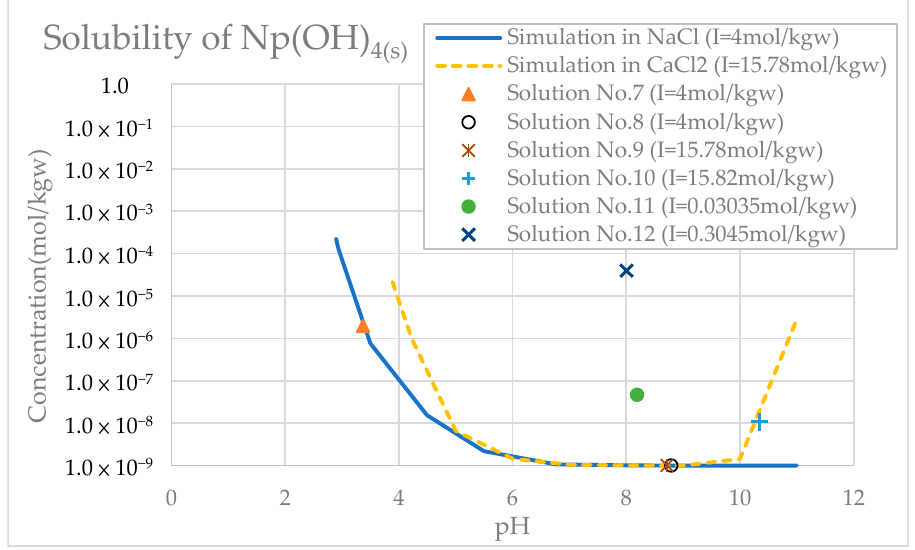
Figure 4. Comparion of the total dissolved concentration of Np(OH) 4(s) in relation to the pH, as calculated using the data of solutions No.7, 8, 9, 10, 11 and 12.